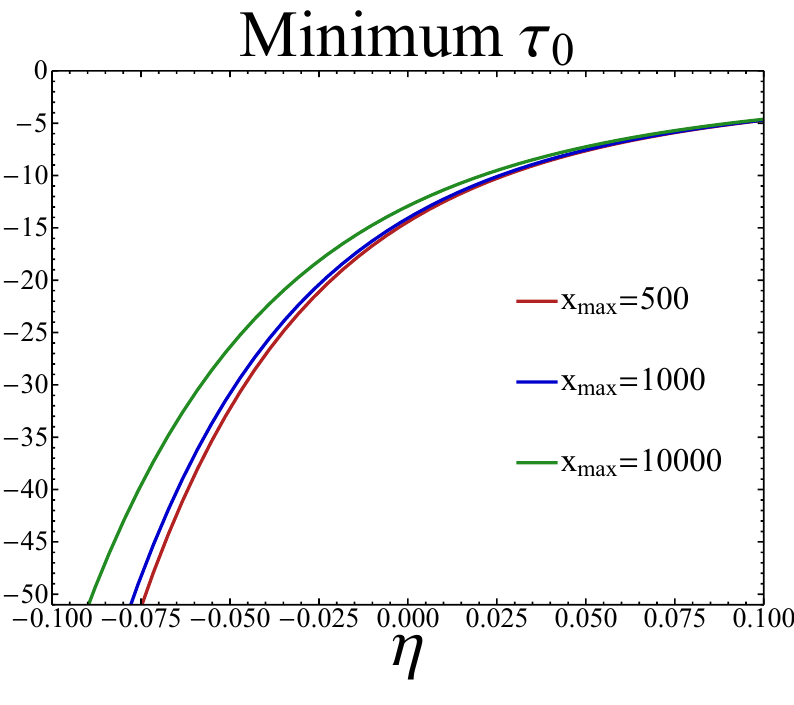
Figure 1 . Lower bound on the parameter (cid:28) 0 to avoid both ghosts and tachyonic roots below x max , for x max = 500 (red), 1000 (blue), or 10000